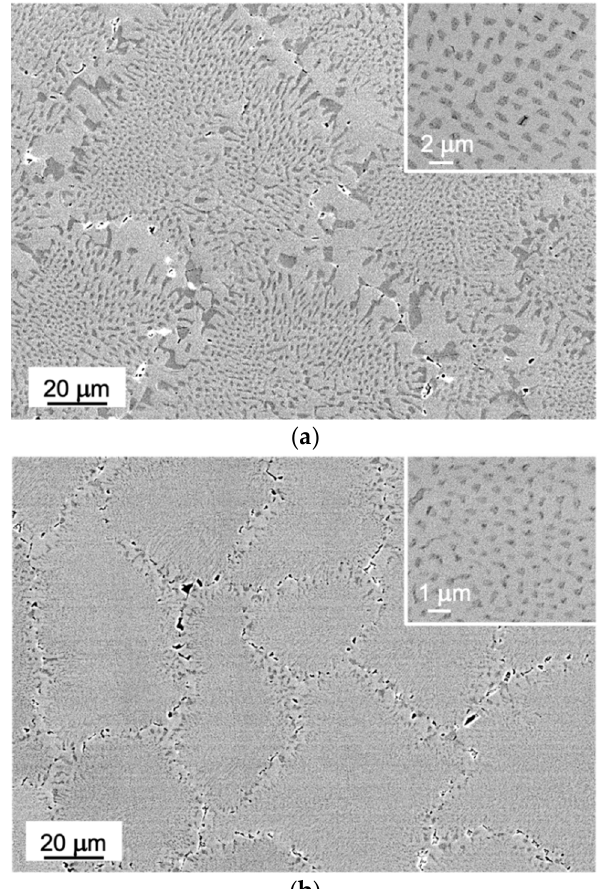
Figure 1. SEM micrographs of the transverse cross section of ( a ) Co0.12-50 and ( b ) Co0.15-750 eutectic rods. Insets: amplification of the microstructure inside the colony.